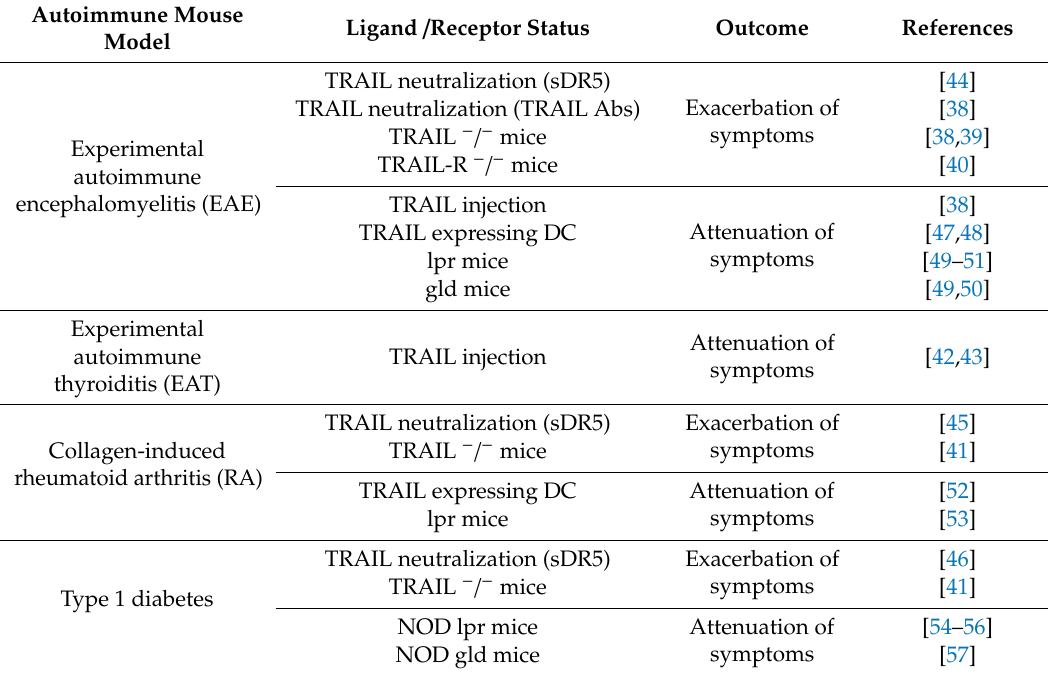
Table 1. The role of Tumor Necrosis Factor-Related Apoptosis Inducing Ligand (TRAIL) / TRAIL-R